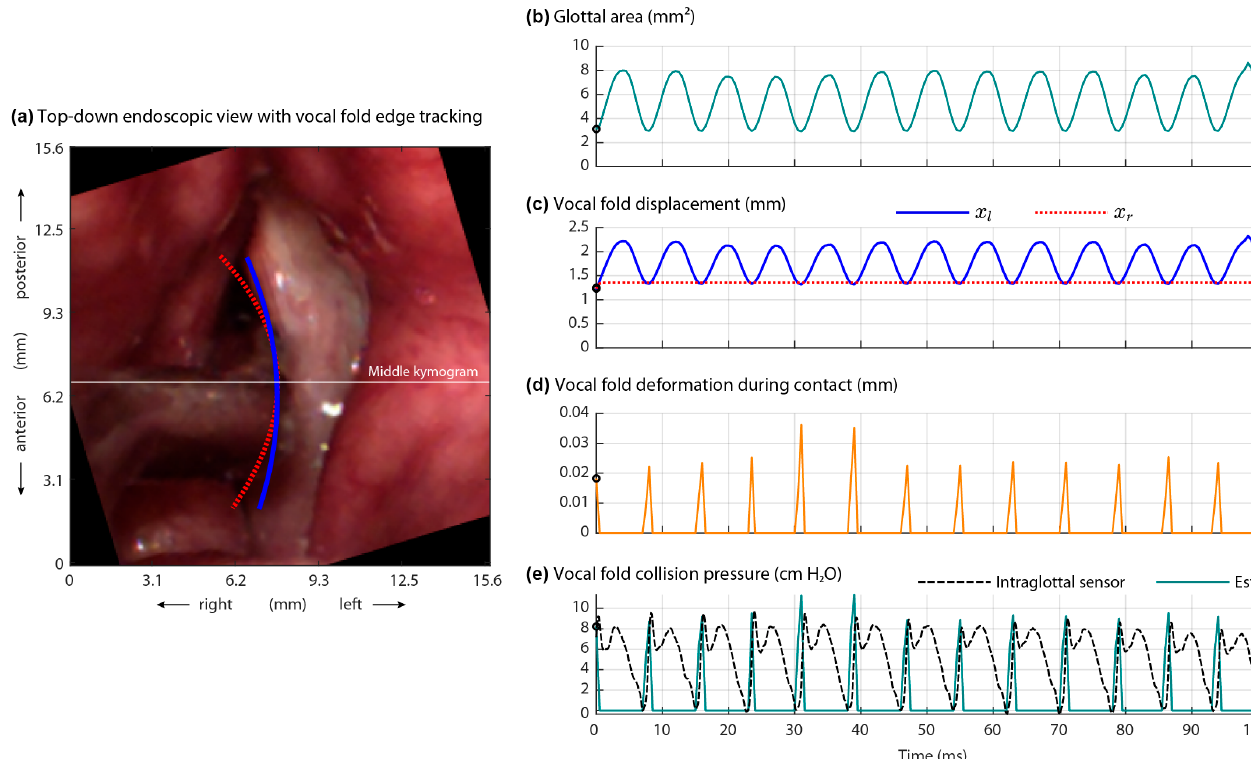
Figure 5. Results of the Hertzian contact pressure analysis method of Díaz-Cádiz et al. [45]. Shown are the ( a ) first high- speed videoendoscopic frame with vocal fold edge tracking, ( b ) measured glottal area waveform, ( c ) vocal fold displacement at the middle digital kymogram of the left ( x l ) and right ( x l ) folds using a Kalman filter, ( d ) vocal fold deformation during contact (model output), and ( e ) vocal fold collision pressure as estimated by the model (Est.) and directly measured by the ISP probe’s intraglottal sensor.